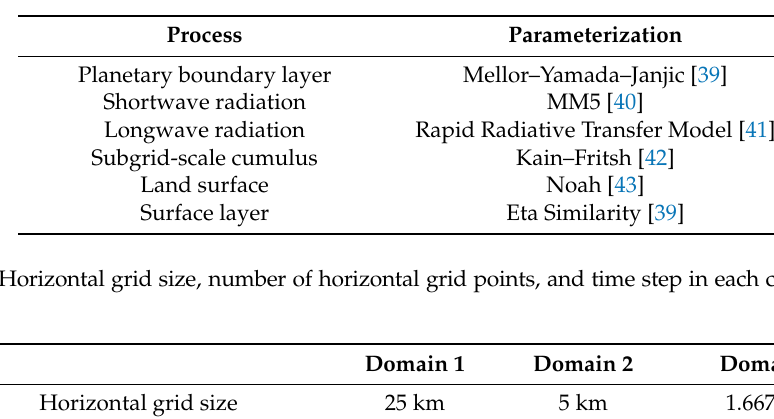
Figure 1. Three nested computational domains with terrain height. Table 1. Physics parameterizations used in this study.